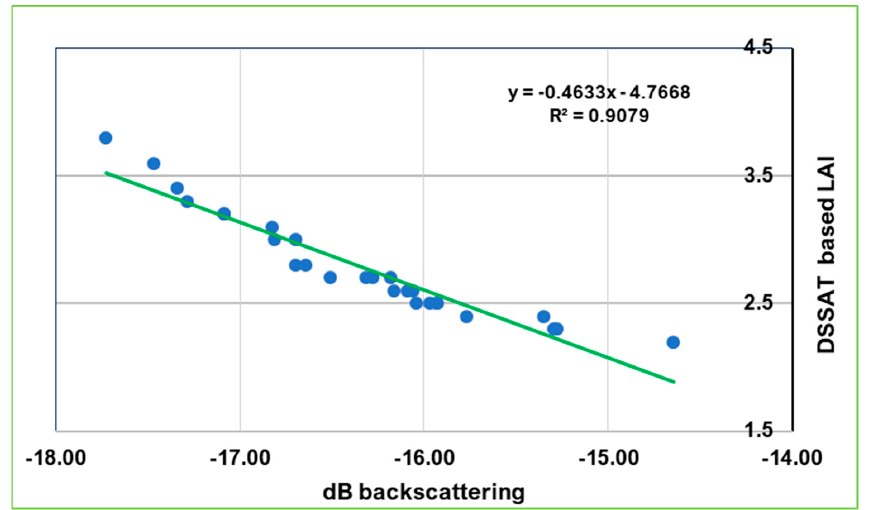
Figure 4. Integration of remote sensing and DSSAT simulation model for yield estimation.